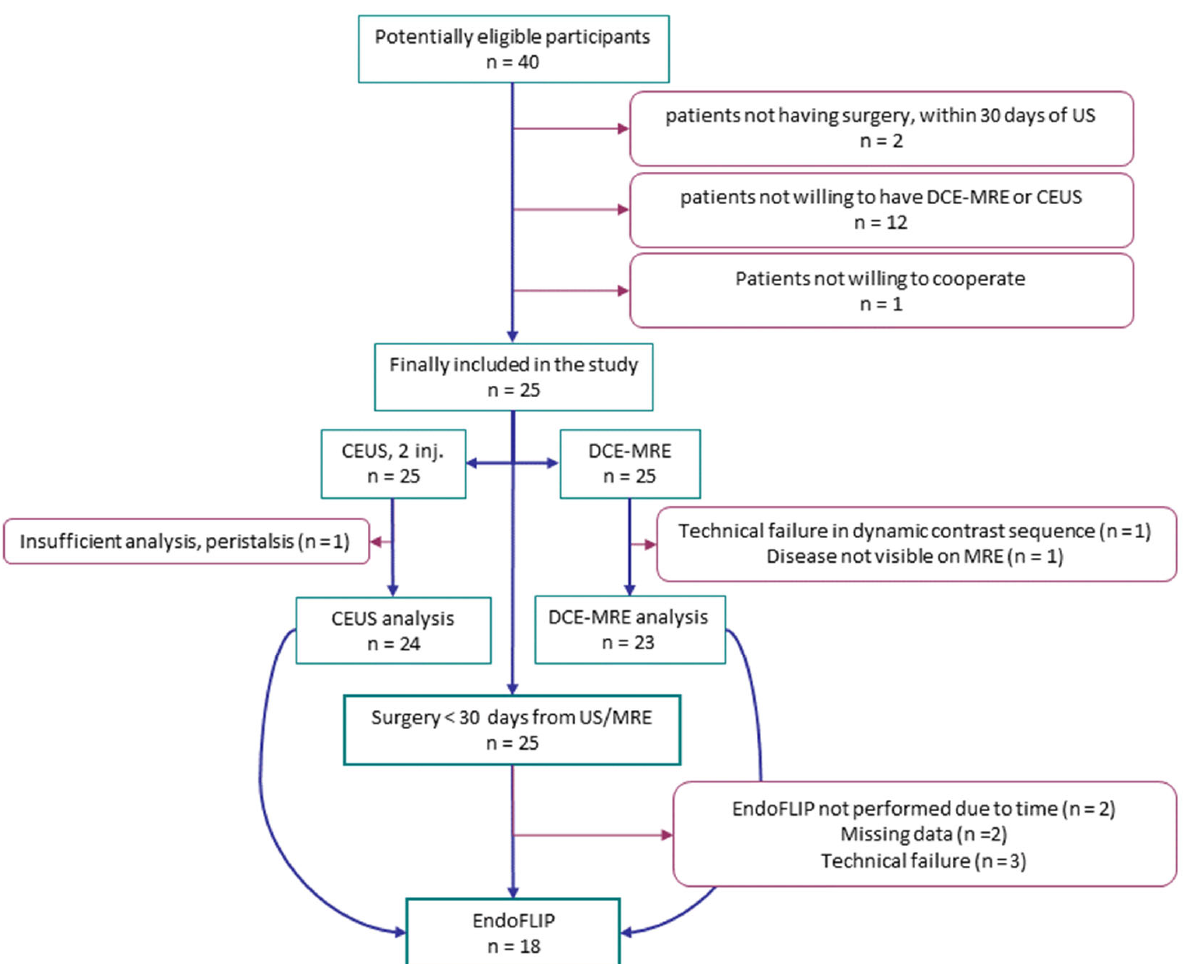
Figure 1. Flow chart of patients included in the study.